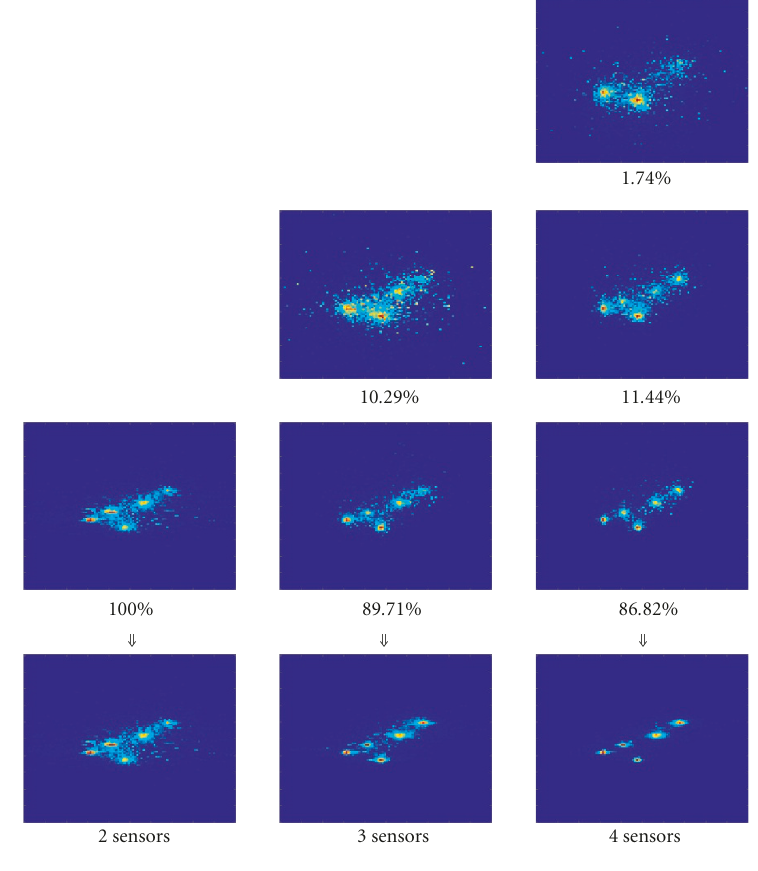
Figure 4: Soft DESPRIT histograms associated with the low to high power source estimates for 5 sources and 2, 3, and 4 anechoic mixtures. The average percentage power associated with each histogram is also given as a label to each component histogram. Each plot has an x -axis with units − 2 . 5 ≤ (cid:27) δ ≤ 2 . 5 samples and a y -axis with units − 2 . 5 ≤ log( (cid:27) α ) ≤ 2 .